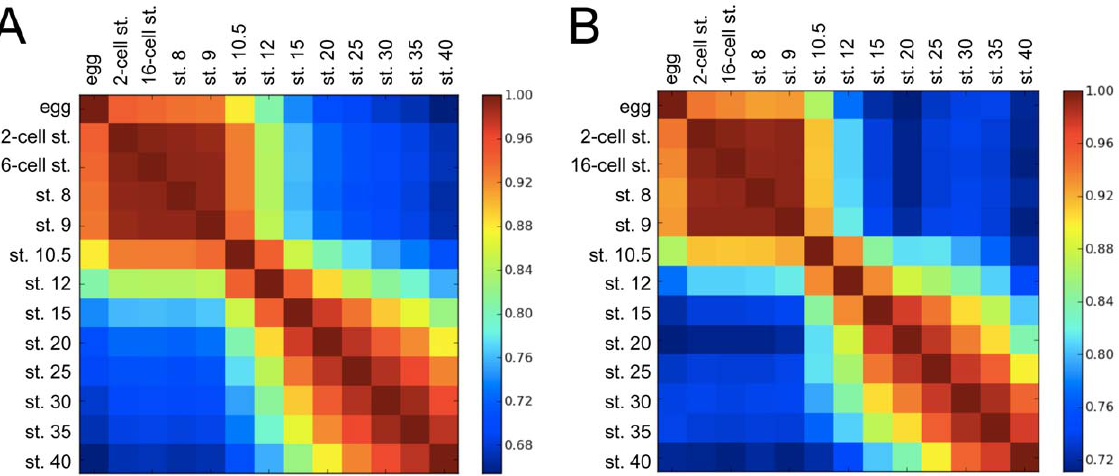
Figure 2. Global comparisons of total and glycogene transcriptomes during Xenopus embryogenesis. Heat map of the correlation coefficient matrix. The color of each square indicates the difference at a specified developmental stage. By definition, diagonal squares have zero divergence. Color scales indicate the correlation coefficient. (A) Global genes; (B) ‘‘ Xenopus glycogenes.’’ Egg, unfertilized egg; st., stage.